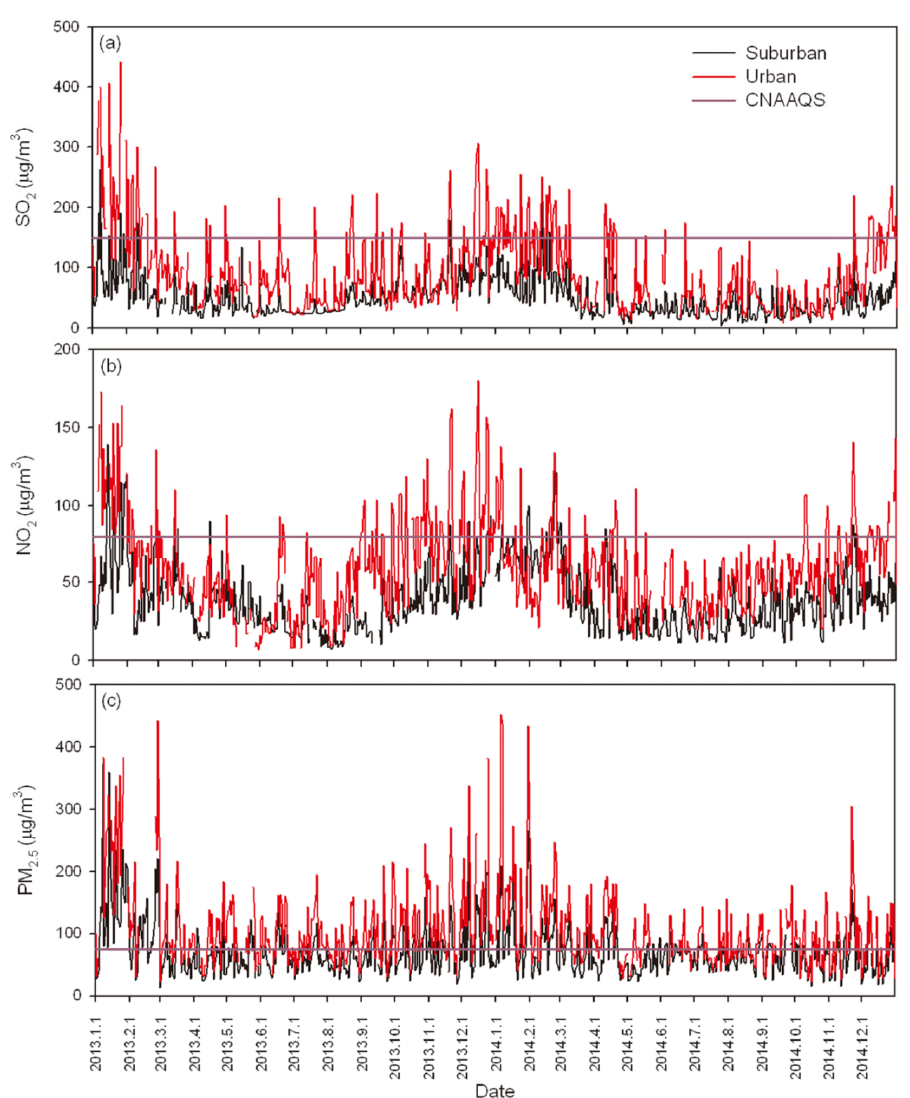
Figure 1. Time series distributions of SO 2 , NO 2 and PM 2.5 in Jinan during 2013 to 2014. The horizontal lines in ( a ); ( b ) and ( c ) represent the standard daily average limits of SO 2 (150 μ g/m 3 ), NO 2 (80 μ g/m 3 ) and PM 2.5 (75 μ g/m 3 ) in Chinese National Ambient Air Quality Standards (CNAAQS), respectively.